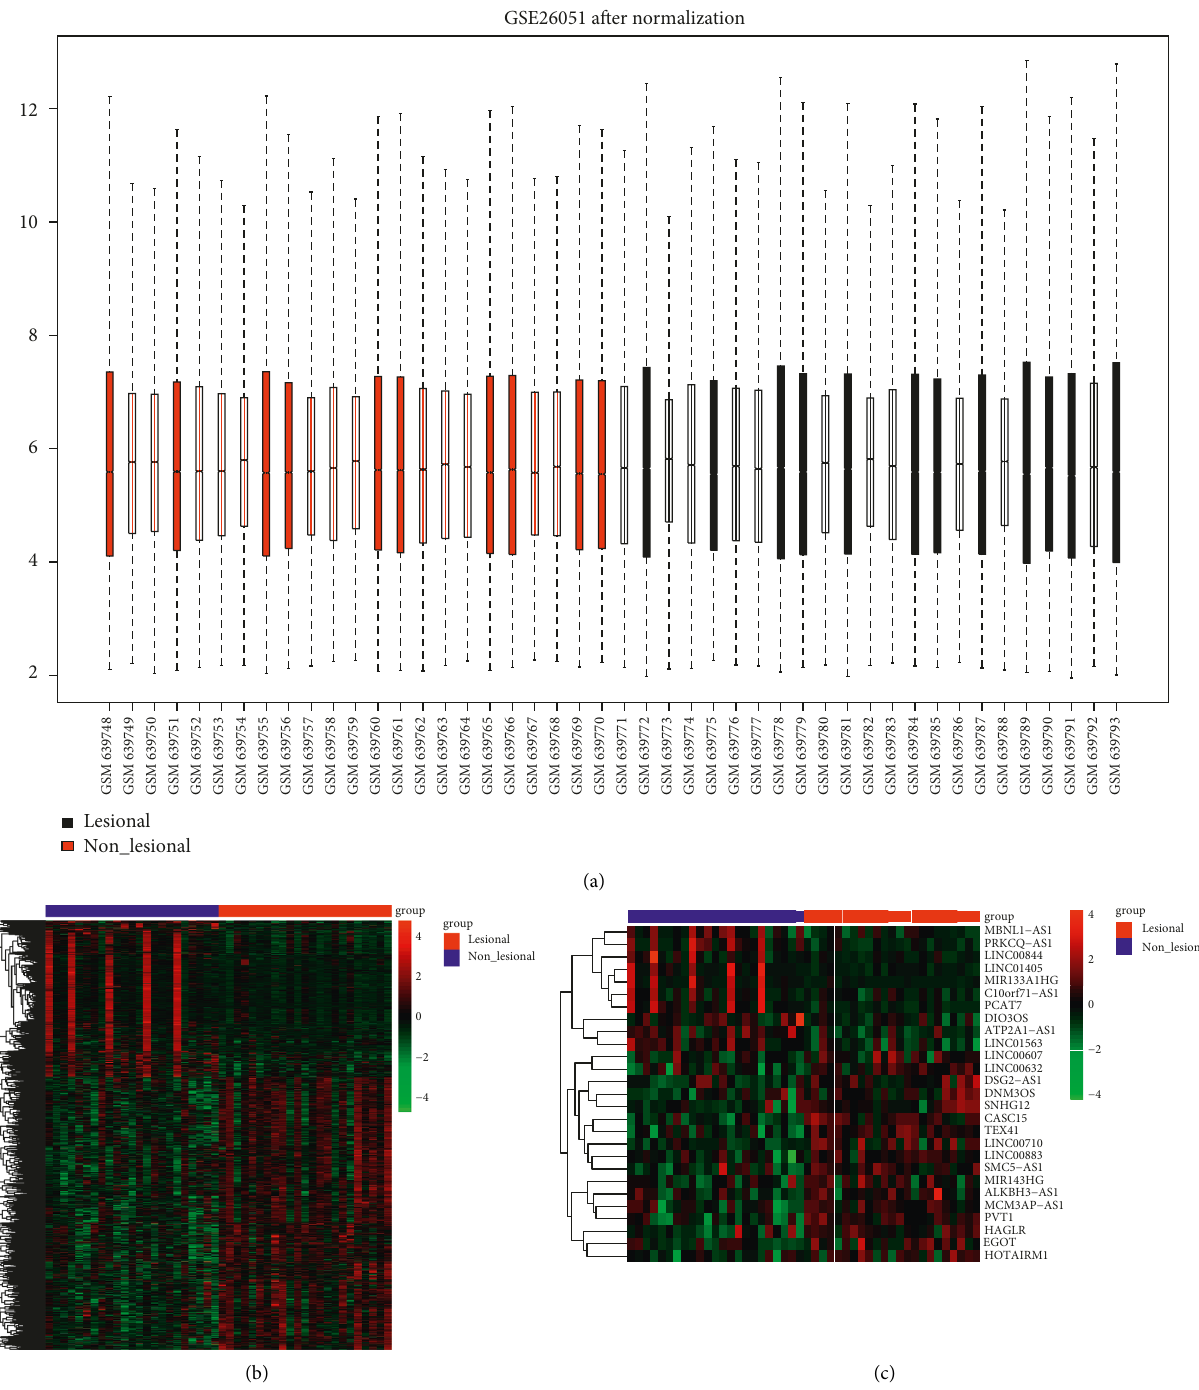
Figure 1: Identification of DEmRNAs and DElncRNAs. (a) Box graph of expression level distribution of sample genes. (b) Heatmap of DEmRNAs. (c) Heatmap of